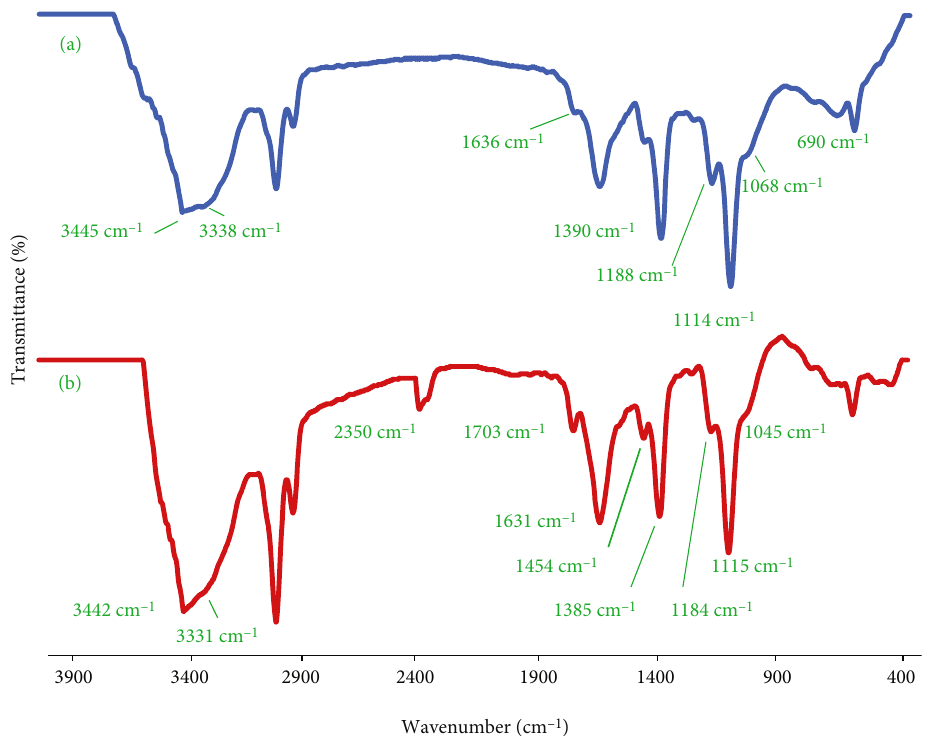
Figure 3: FT-IR spectra for stepwise synthesis of PUr. (a) Am and (b) PUr.